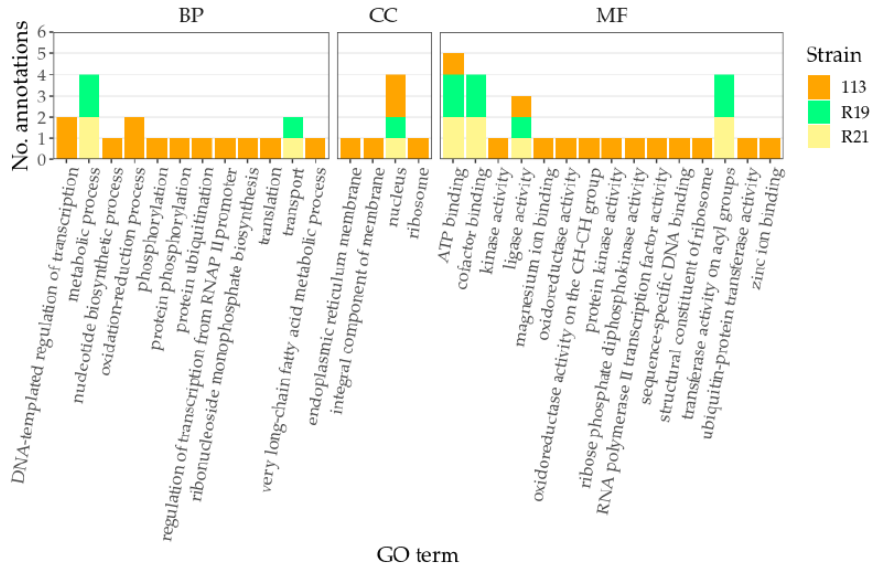
Figure 6. GO annotation frequencies of genes surrounding putative lipoxygenase genes. Two sets of genetic neighbors were inspected for 113, compared to only one set for strains R19 and R21 each. Panels are labeled by GO parent terms: BP, biological process; CC, cellular component; MF, molecular function.